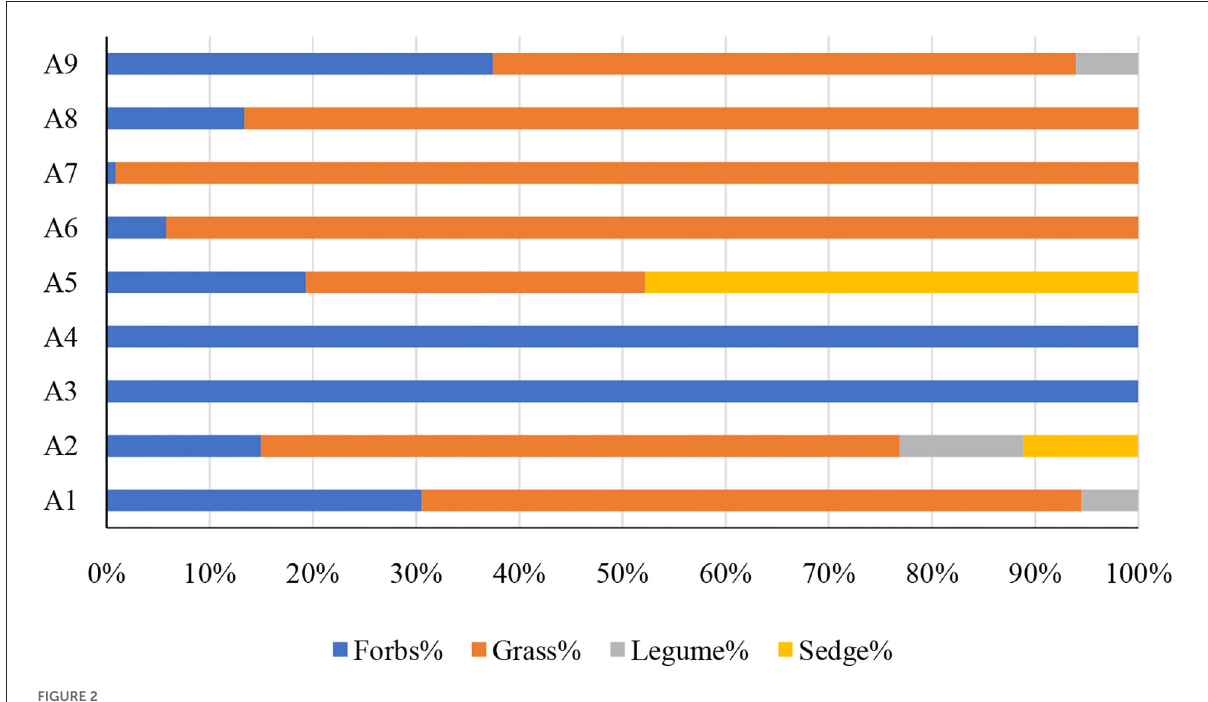
FIGURE2 Percentage of important values of different plant functional groups (PFGs).